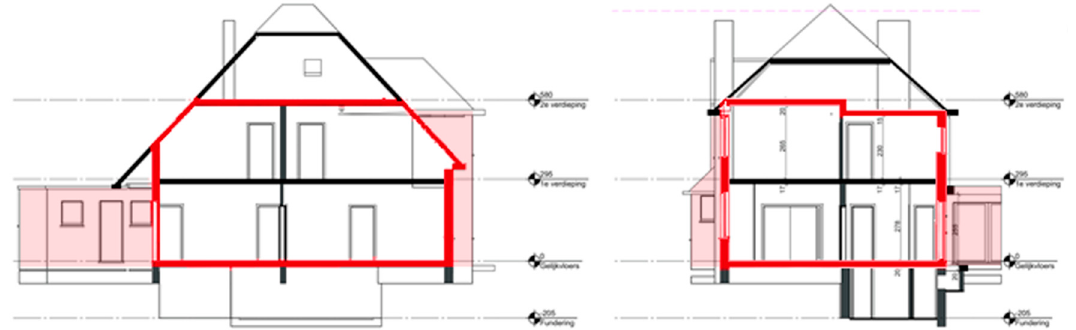
Figure 3. Cross sections AA’ ( left ) and BB’ ( right ). The building fabric of which the HLC will be assessed, is colored red.